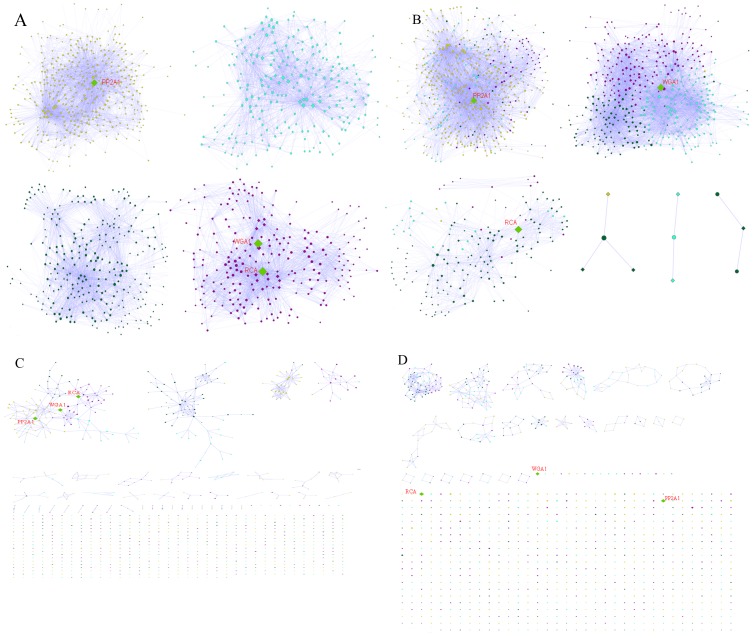
Communities generated by four methods are shown.(a) Mod-CSA generated communities are shown. In each community, glycans nodes are represented by circles whereas the protein nodes are shown as diamonds. From the figure it can be seen that all the nodes in a network have been assigned to a community. Community 1 has PP2A1 as hub node where as Community 4 has two hub nodes, WGA1 and RCA. (b) Greedy algorithm generated communities are shown. The nodes are color coded as per the Mod-CSA result. Each of the first three communities (community 1 to 3) contain a hub node where as communities 4-6 have only a few nodes.(c) MCODE generated communities are shown. Many nodes are not clustered, and the three hubs are grouped into one community. (d) MCL generated communities are shown many nodes are not clustered at all. Hub nodes are not clustered with any other nodes.